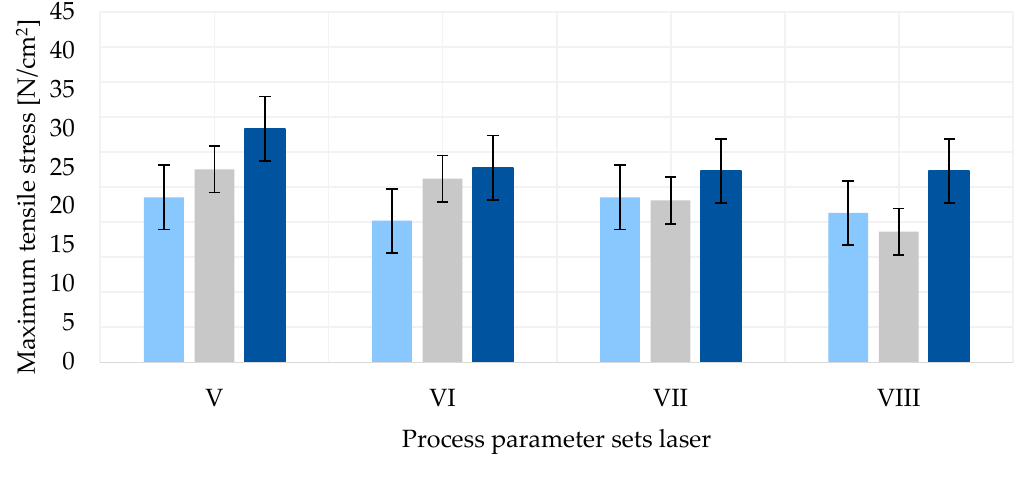
Figure 5. Adhesion force of silicon – graphite anodes dried by laser.